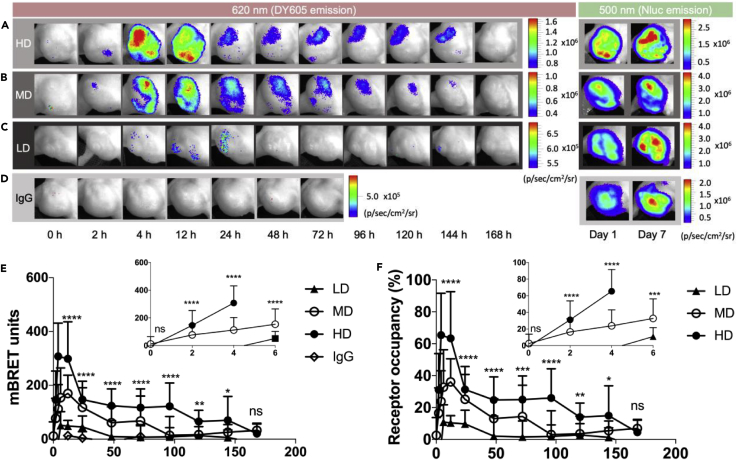
DY605-Cetuximab/NanoLuc-EGFR Receptor Occupancy (RO) Measurement In Vivo(A) BRET images (at 620 nm) of mice that received 50 mg/kg (HD) of DY605-cetuximab. The BRET measurement of HD group at 6 h post administration was absent due to a problem in data collection.(B) BRET images (at 620 nm) of mice that received 8.5 mg/kg (MD) of DY605-cetuximab.(C) BRET images (at 620 nm) of mice that received 1.0 mg/kg (LD) of DY605-cetuximab.(D) BRET images (at 620 nm) of control group mice. The mice in control group received 1.9 mg/kg of DY605-IgG. DY605-IgG showed no binding with NLuc-EGFR during the study. For panels (A–D), the representative NanoLuc images (at 500 nm) of each dose group at day 1 (the first day of in vivo RO study) and day 7 (the last day of in vivo RO study) are shown on the right.(E) Quantified NanoLuc-EGFR/DY605-cetuximab binding for the 1.0 mg/kg (LD), 8.5 mg/kg (MD), and 50 mg/kg (HD) groups and 1.9 mg/kg DY605-IgG (control). For HD, MD, and LD groups, the bindings peaked at about 4–12 h and experienced biphasic decay after 12 h post injection. The BRET ratios for 1.0 mg/kg group were compared to DY605-IgG group by a two tailed, unparied Student t test. The BRET ratios for 1.0 mg/kg group was not significantly different with IgG controls at 48 h post injection (p = 0.23). No binding was observed for DY605-IgG.(F) Quantified RO in live mice. Quantification of DY605-CTX RO revealed a maximum average RO for the HD, MD, and LD groups of 72% ± 26%, 41% ± 14%, and 18% ± 6%, respectively. For (E and F), each data point represents the mean value of at least 15 unique ROIs (n = 2–6 per mice). Error bars represent ±SD. The difference in RO across groups was evaluated using ordinary one-way ANOVA. ****p ≤ 0.0001, ***p ≤ 0.001, **p ≤ 0.01, *p ≤ 0.05, ns: p > 0.05.